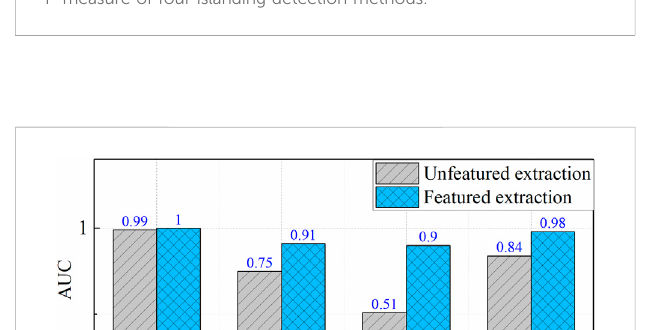
FIGURE 6 F-measure of four islanding detection methods.